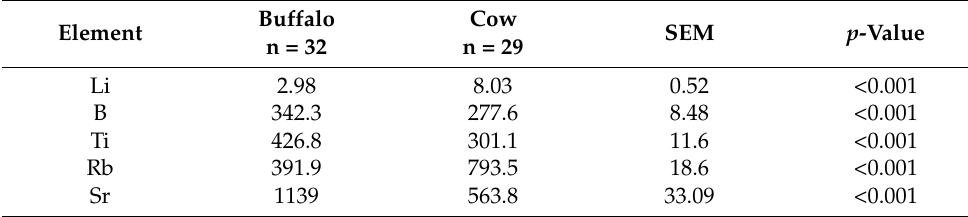
Table 3. Non-essential trace element concentrations ( µ g/L) in buffalo and cow milk.